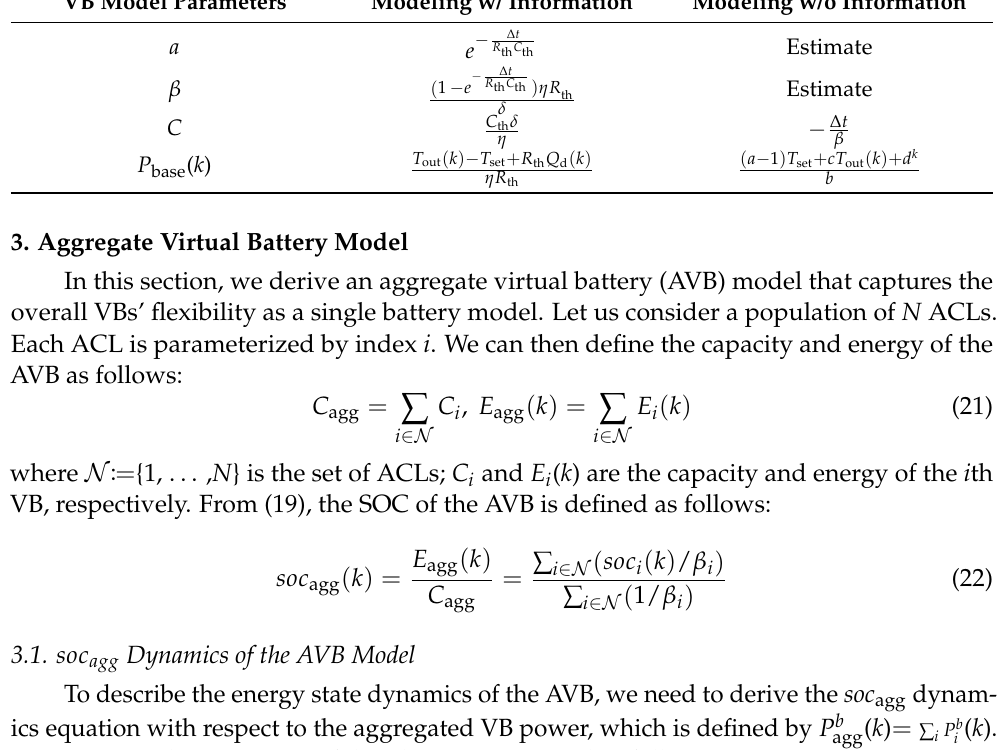
Table 2. Comparisons of the VB model parameters. VB Model